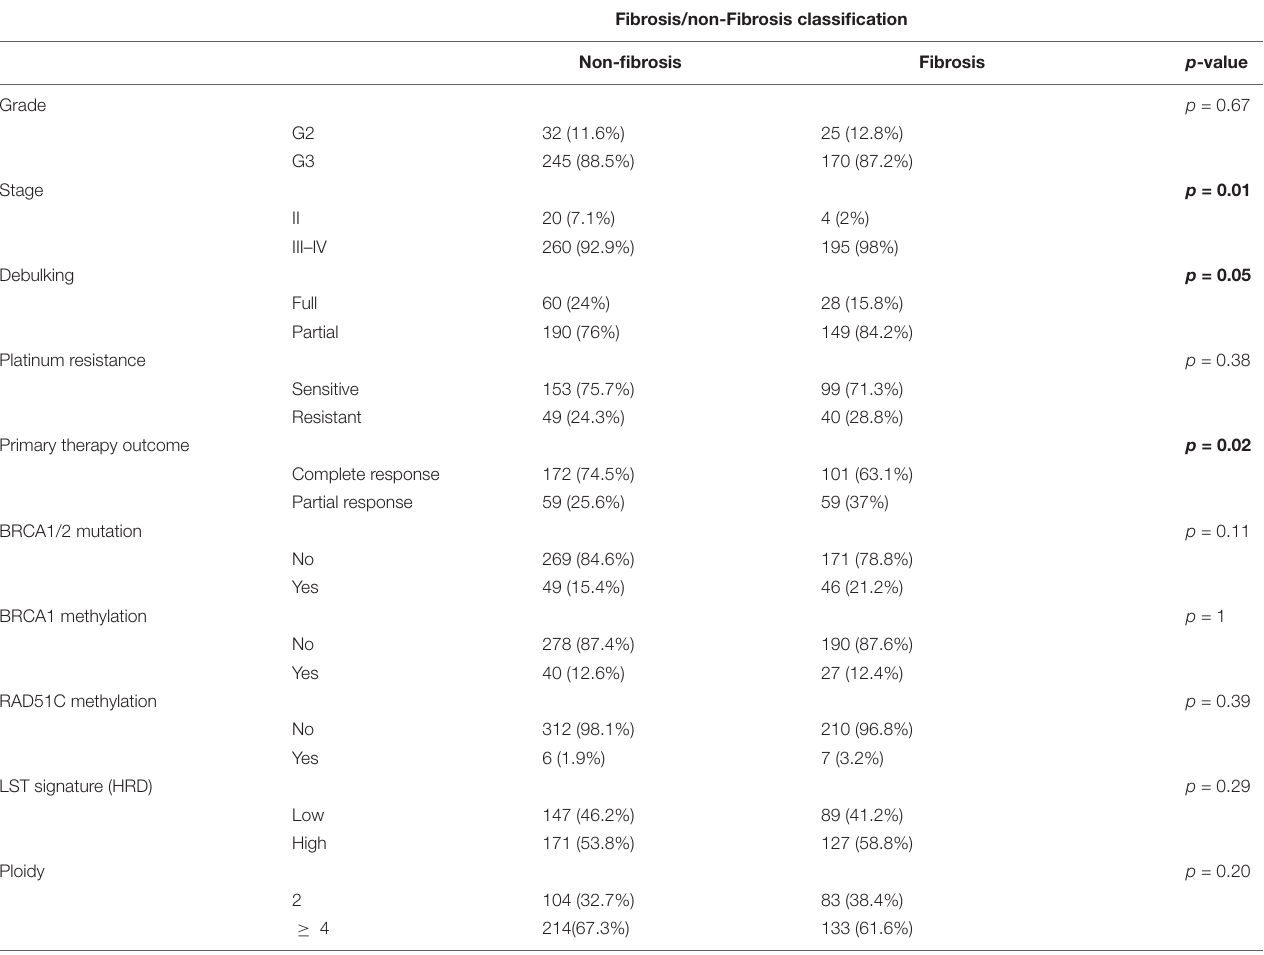
TABLE 2 | The association between transcriptomic signatures and clinical